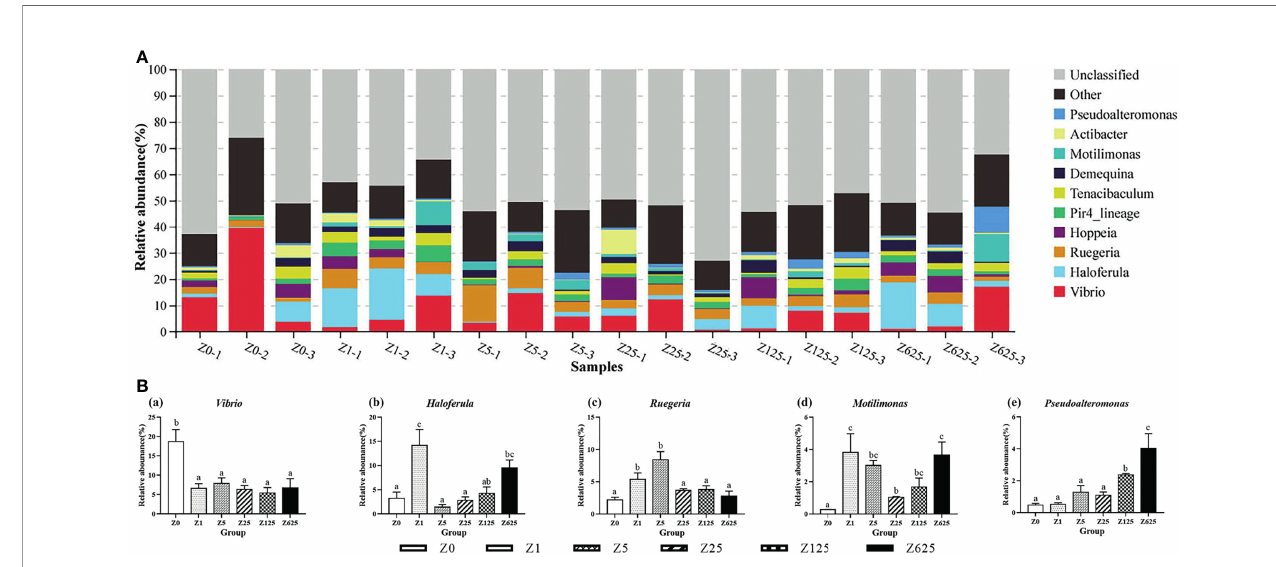
FIGURE 8 | Structure and composition of the intestinal bacterial communities in Litopenaeus vannamei fed different levels of zymosan-A (genus level). (A) Species distribution stacking of the treatment groups. (B) Relative abundances of the top 5 genera. Different letters indicate signi fi cant differences ( p <